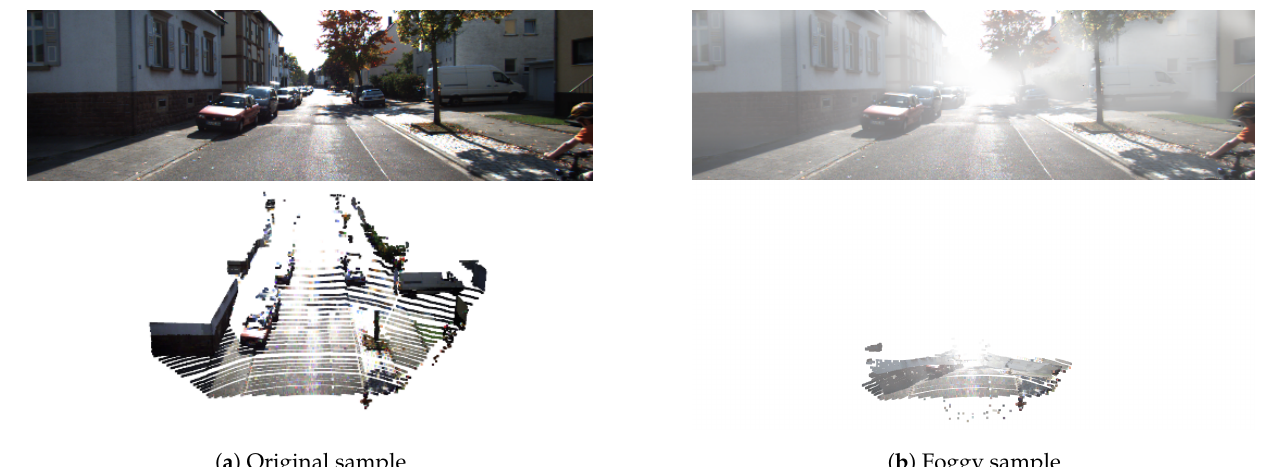
Figure 1. An example of distortion of an image and a point cloud in the proposed dataset. Note that the color of each point in the point cloud is the color of the corresponding pixel in the image (for visualization only). ( a ) shows the original sample from the KITTI dataset [16] with the image above and point clouds below collected by Velodyne HDL64 S2 LiDAR [16,17]. ( b ) shows the image and the point cloud simulated in foggy conditions with visibility equal to 52 m ( V = 52 m) from the proposed dataset. Arising from receiving back-scattered light from water drops, fog makes the image have lower contrast and causes incorrect point measurements in the point